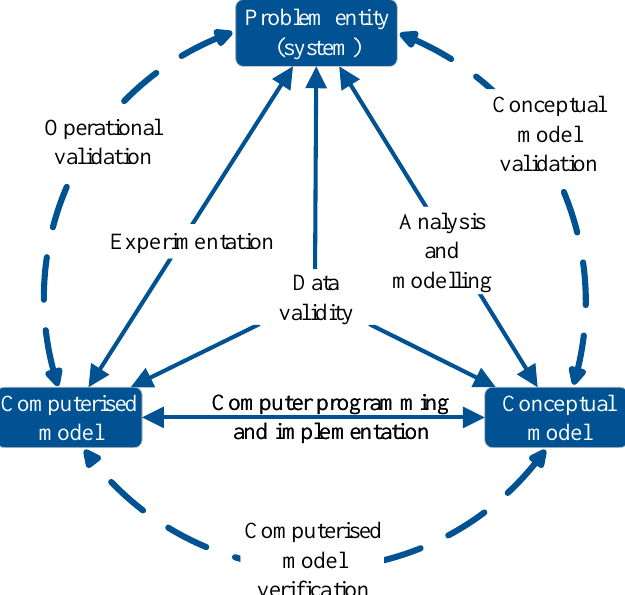
Figure 1. Simplified model development process according to Sargent